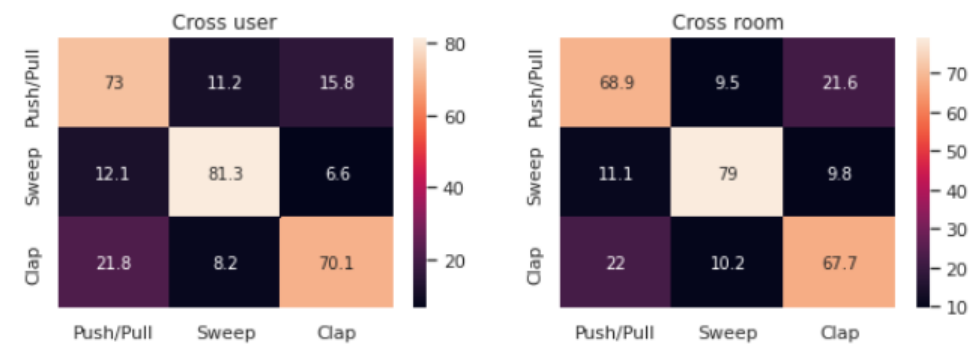
Figure 23. Cross user and cross room confusion matrices of the final ADA model (in % w.r.t. overall class